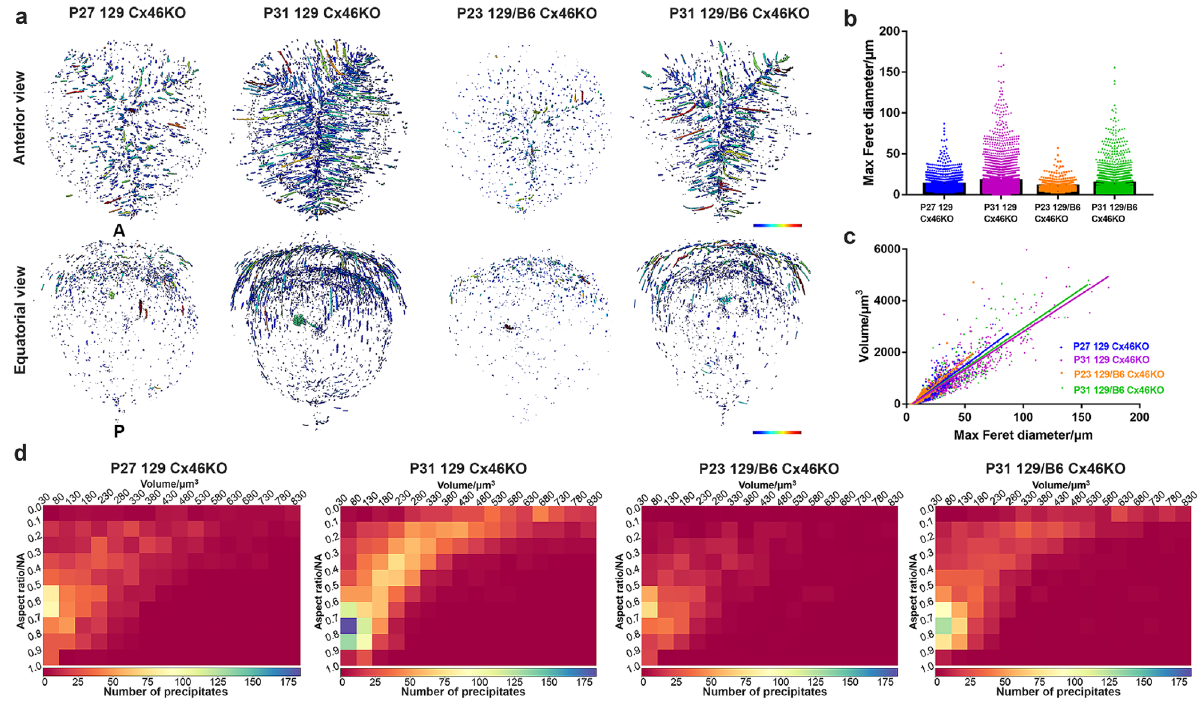
Figure 3. Precipitate geometrical parameter measurement of Cx46KO lenses. The same individual lenses in Fig. 2 were analyzed. ( a ) The distribution and quantification of precipitates were measured by the Max Feret diameter (length) in the cataract regions of 129 Cx46KO and 129/B6 Cx46KO lenses, scanned with the resolution of 0.65 μm/pixel. Individual precipitates, in both anterior and equatorial views, were colored based on the color bar, magenta/red for long precipitates and blue/green for short precipitates. Lens anterior (A) and posterior (P) poles were indicated on the left equatorial image. ( b ) A bar graph shows Max Feret diameter measurement of four different Cx46KO lenses. ( c ) The relationship between Max Feret diameter and volume of the precipitates in four different Cx46KO lenses. ( d ) Heat maps reveal the relationship among aspect ratio, volume, and number of precipitates in cataracts of Cx46KO